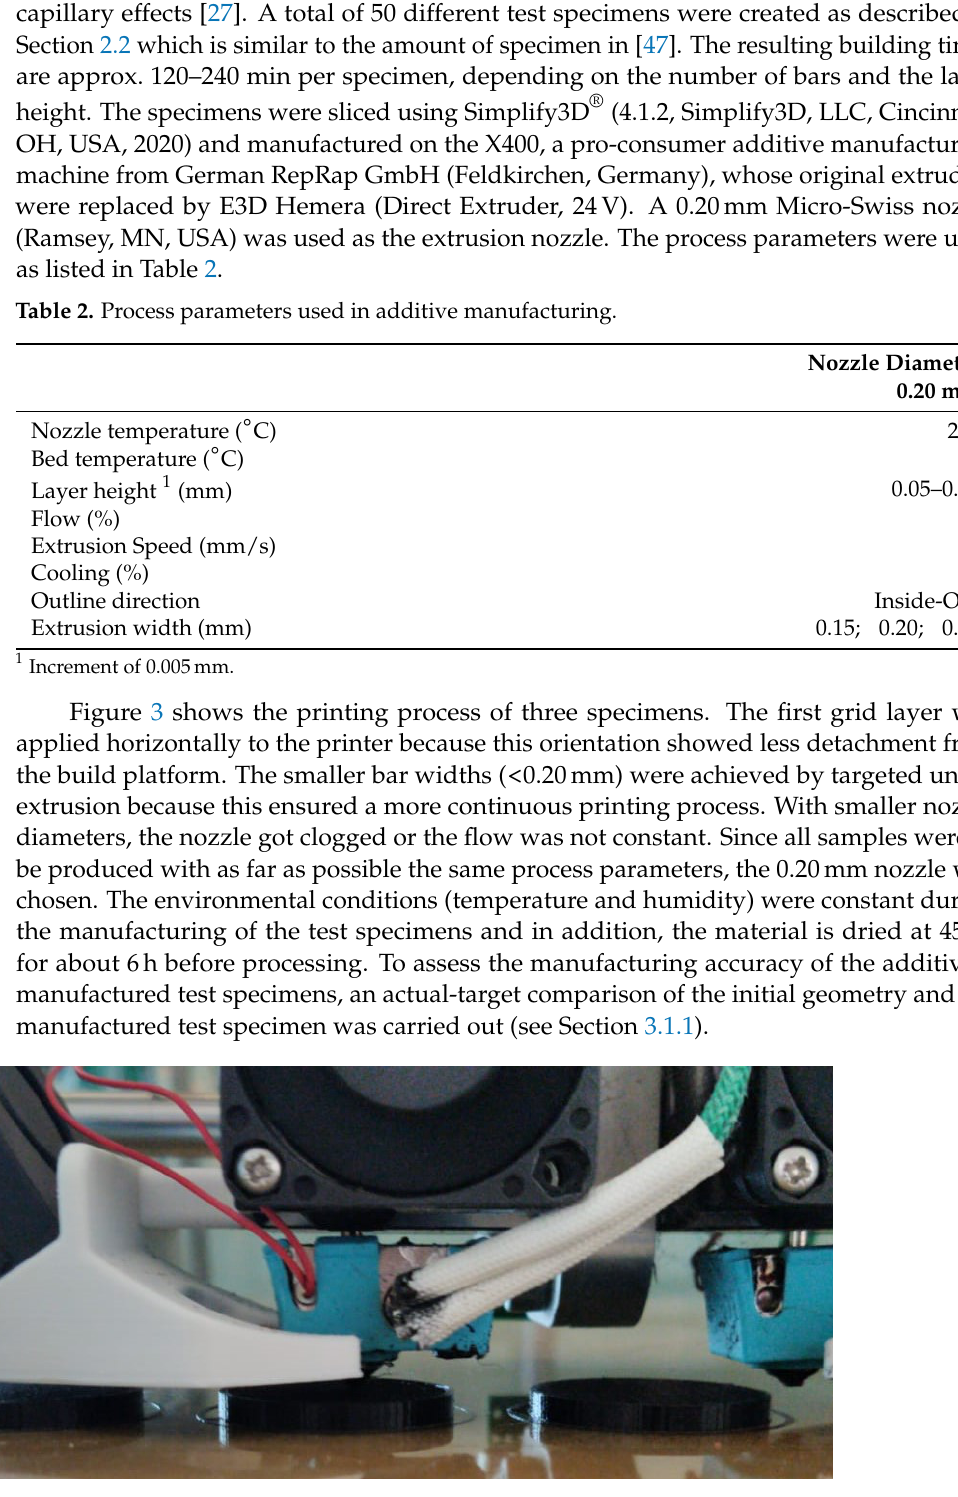
Figure 3. Additive manufacturing of three test specimens using material extrusion. Used 3D printer: X400, ppro-consumer additive manufacturing machine from German RepRap